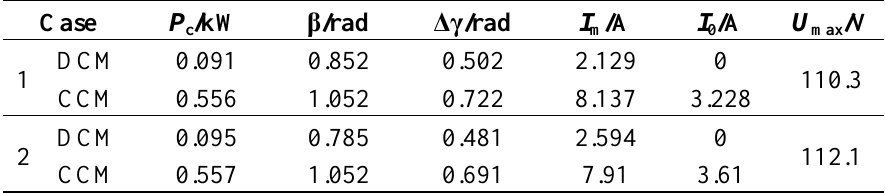
Table 2. Characteristic parameters of measured curves.